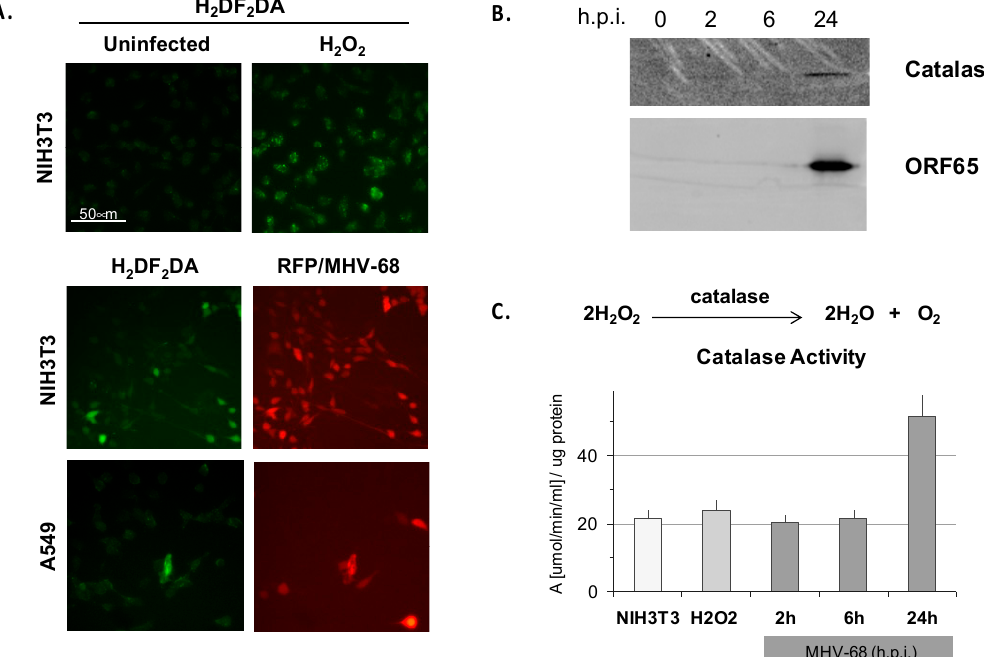
Figure 5. MHV-68 infection induces reactive oxygen species (ROS) in cultured cells. ( A ) Murine NIH3T3 fibroblasts or human lung A549 cells were infected (m.o.i. = 1) in triplicate with MHV-68 expressing red fluorescent protein (RFP/MHV-68, red channel ). Supernatants were removed 20 h.p.i., and the cells were incubated with H 2 DF 2 DA and imaged by epifluorescence microscopy. Hydrogen peroxide (H 2 O 2 ) was a control for induction of ROS leading to oxidative fluorescence of H 2 DF 2 DA (green channel) . ( B ) NIH3T3 cells infected in triplicate with WT MHV-68 were lysed at the indicated times, proteins separated by SDS-PAGE, and Western blots probed for catalase protein and MHV-68 lytic antigen (ORF65) with specific antibodies and electrochemiluminescent secondary antibody detection. ( C ) Induction of ROS measured by catalase activity assay. NIH3T3 cells in triplicate were untreated, treated with H 2 O 2 for 20 h, or infected with WT MHV-68 for the times indicated; cells were lysed and aliquots measured for protein content by Bradford and catalase activity assays according to a standard curve; only for 24 h, p < 0.05, two-tailed t -test; error bars represent S.E.M.